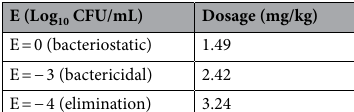
E (Log 10 CFU/mL) Dosage